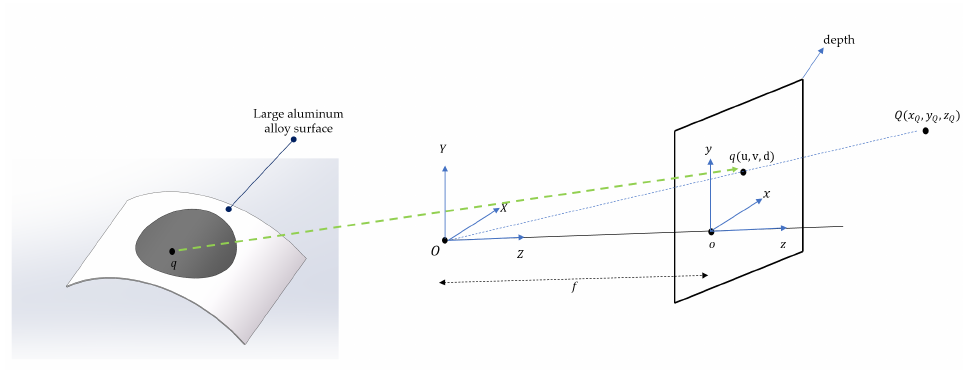
Figure 5. Correspondence between depth map and point cloud.